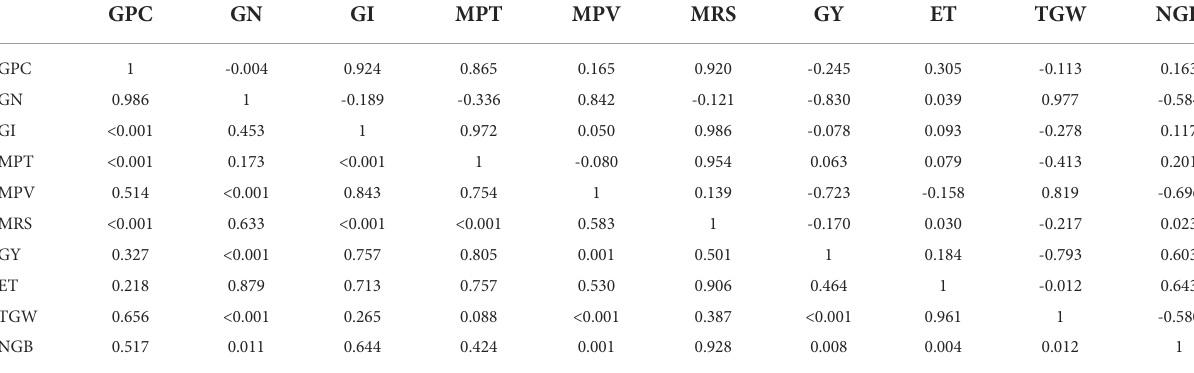
TABLE 3 Pearson ’ s correlation coef fi cients (above the diagonal) and probability values (below the diagonal) between the quality parameters, yield, yield components, and evapotranspiration of different wheat genotypes subjected to different irrigation